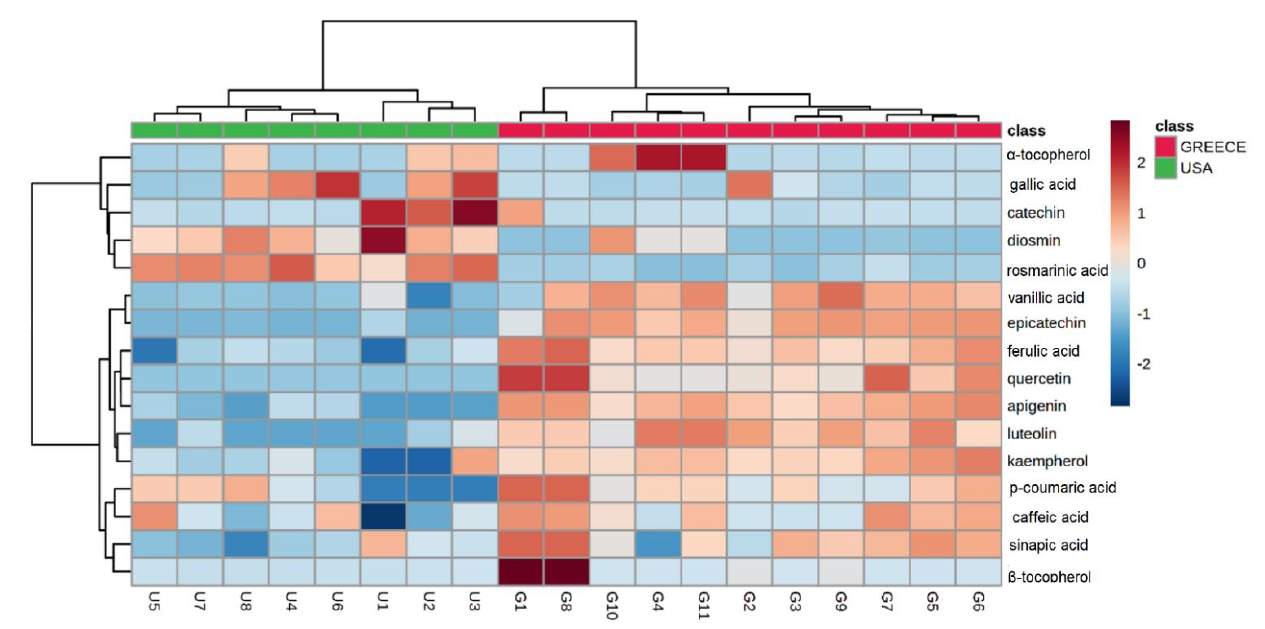
Figure 3. Clustered image map acquired by HCA dendrogram showing pairwise correlation between almonds produced in USA (U1 – U8, in green color on the left-hand side of the heatmap) and Greece (G1 – G11, in red color on the right-hand of the heatmap). The red blocks of the heatmap indicate positive correlations, whereas the blue blocks indicate negative correlations for the clustering of the samples. The lighter shades indicate smaller correlation values.